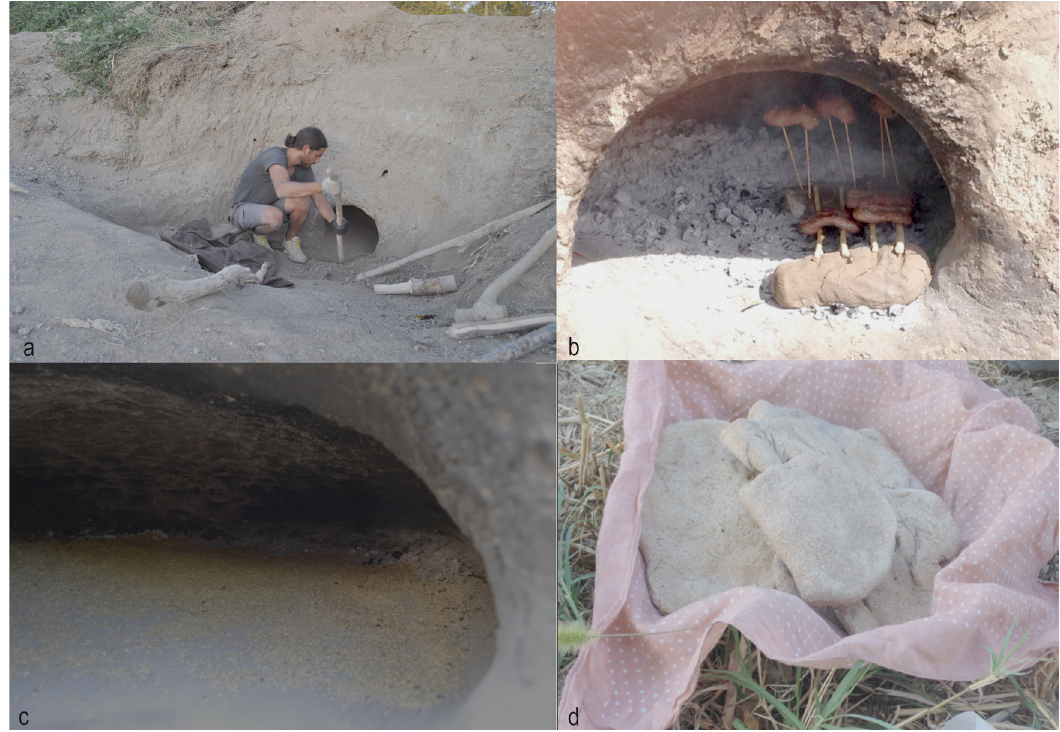
Figure 5: Experimental activities: ( a ) excavating the oven ’ s replica, ( b ) cooking meat using clay andirons, ( c ) roasting barley, and ( d ) unleavened bread baked in the experimental oven ( © Portonovo Project )